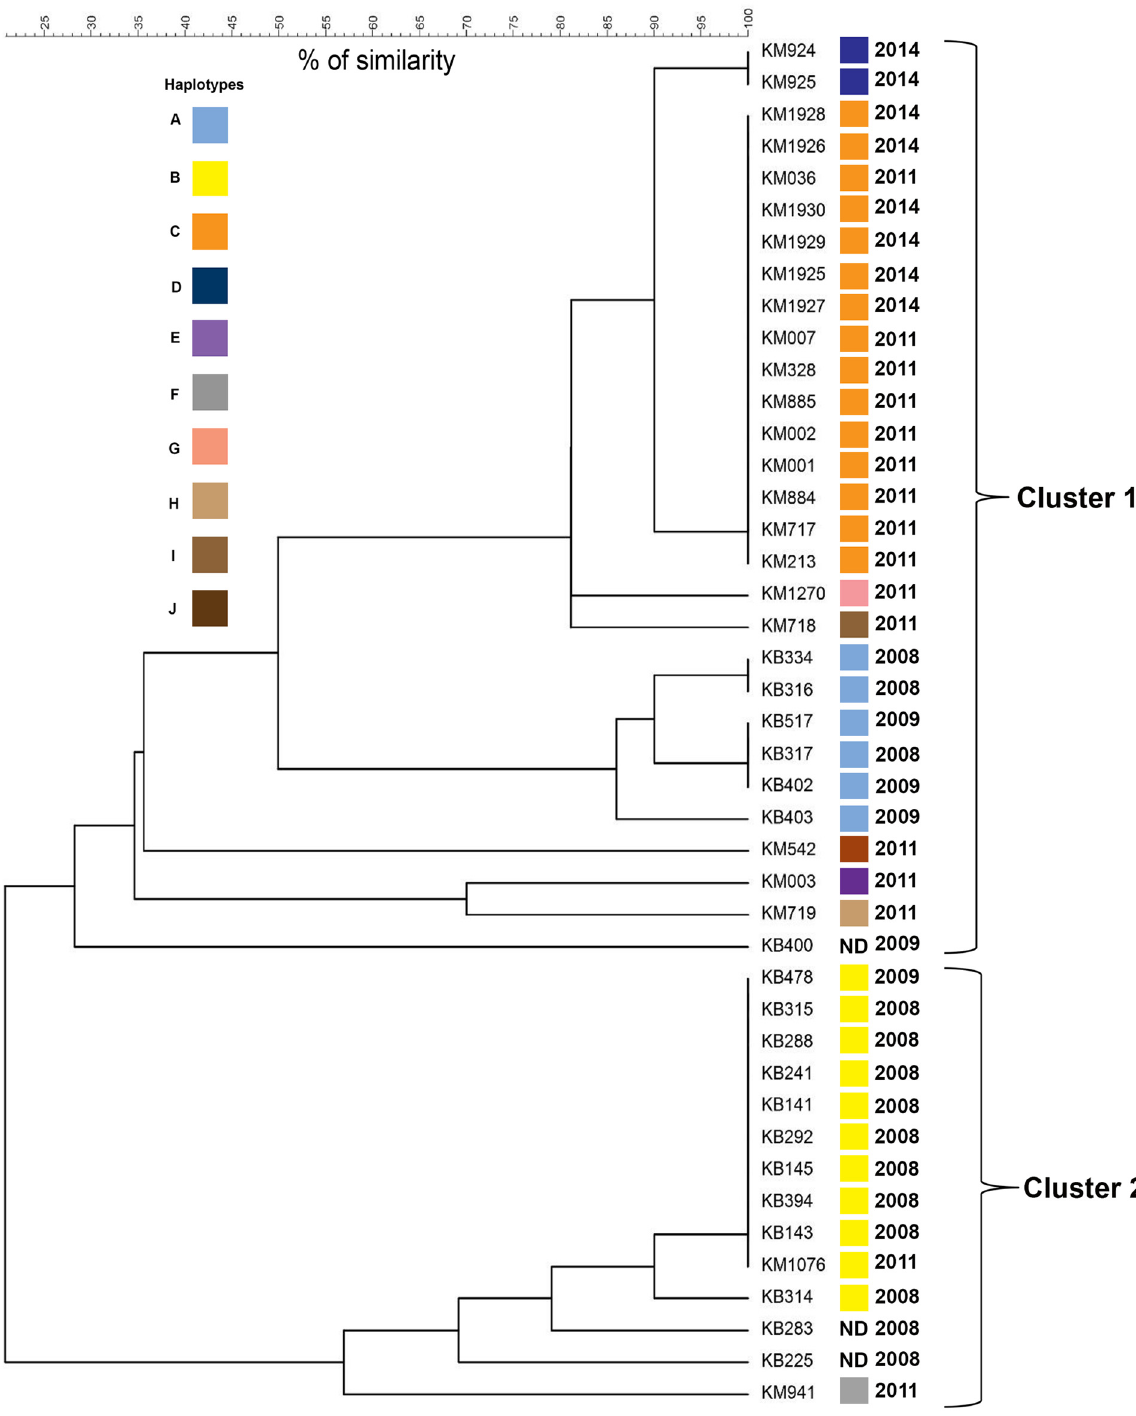
Fig 3. Dendogram showing the clustering of 43 P . falciparum isolates from Kalabakan (KB) and Kota Marudu (KM). The genetic relatedness between microsatellite haplotypes was examined by generating a similarity matrix based on number of tri-nucleotide repeats of each allele from 10 microsatellite loci to construct an unweighted pair group method with arithmetic mean (UPGMA) dendogram. The color coded haplotypes show the distribution of different clonal P . falciparum isolates within each cluster. The major haplotypes (A, B and C) persisted in every year of sampling (2008 and 2009 for Kalabakan; 2011 and 2012 for Kota Marudu). ND, the haplotype was not determined due to missing genotypes or more than 2 alleles of any microsatellite locus.